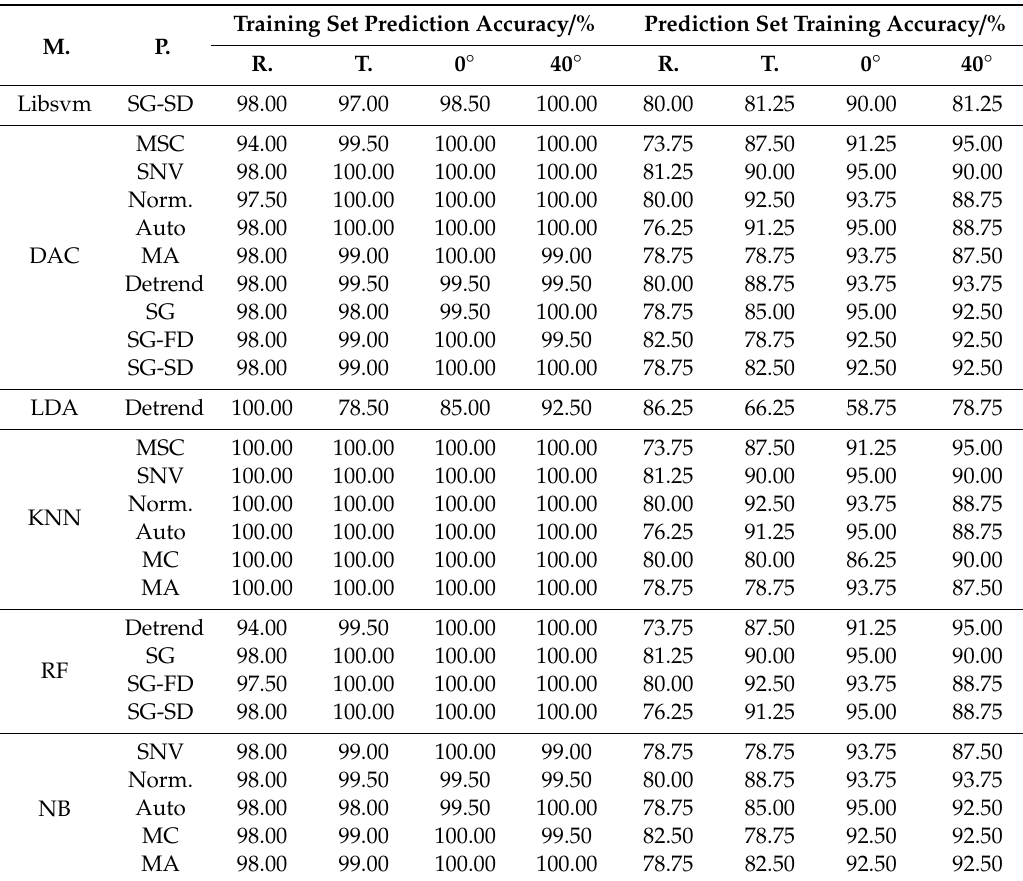
Table 7. The accuracy of the modeling based on CARS (the table shows the higher accuracies).